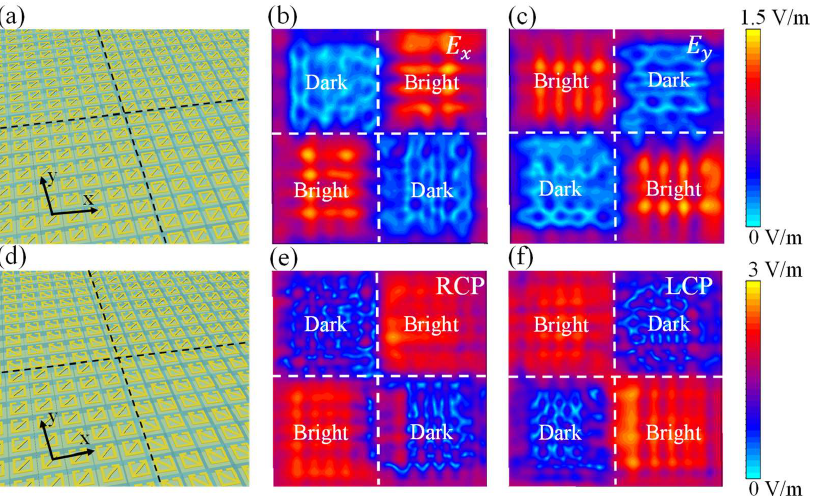
Figure 4. Simulation results of near-field imaging under different polarized waves. ( a ) Schematic diagram of metasurface for linearly polarized wave near-field imaging. ( b ) Simulation diagram of the actual effect of E x polarized wave near-field imaging. ( c ) Simulation diagram of the actual effect of E y polarized wave near-field imaging. ( d ) Schematic diagram of metasurface for circularly polarized wave near-field imaging. ( e ) Simulation diagram of the actual effect of RCP wave near-field imaging. ( f ) Simulation diagram of the actual effect of LCP wave near-field imaging.